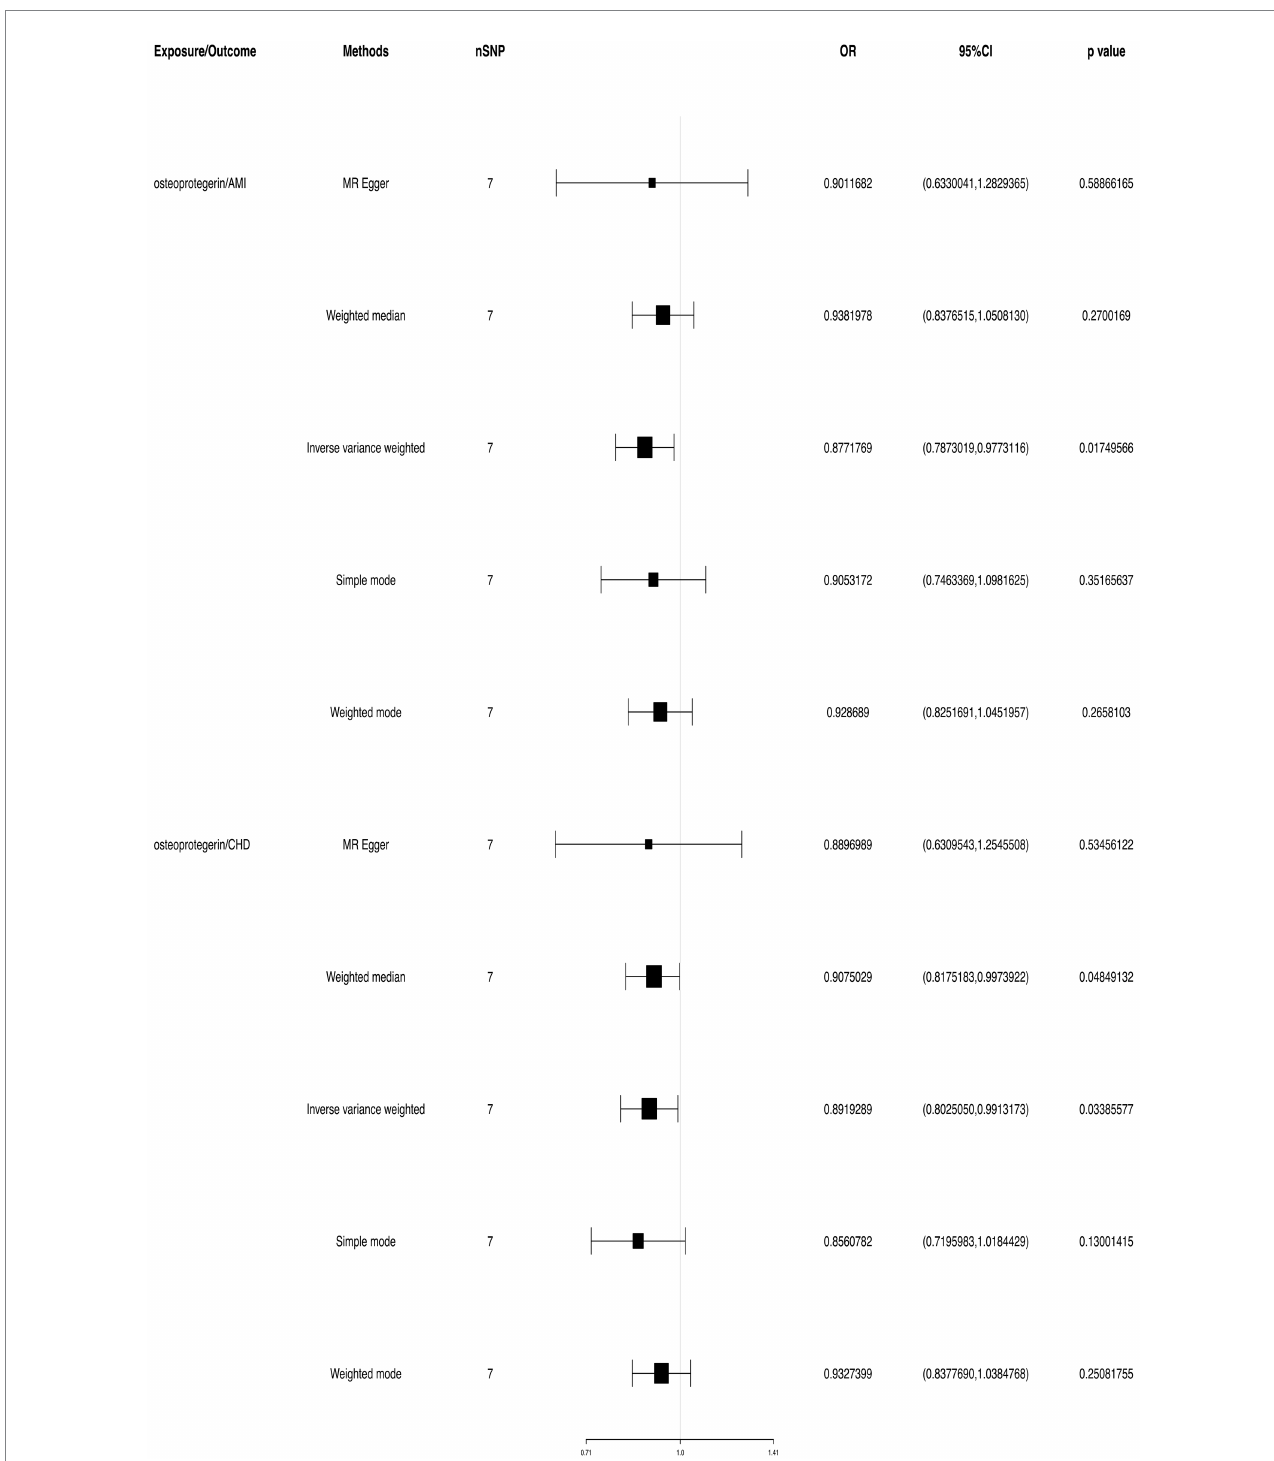
FIGURE 3 TSMR of plasma OPG and risk of AMI and CHD. We used the genome-wide association study (GWAS) of increasing plasma OPG level unit to summarize the statistics. The result was normalized to increase exposure by one unit. IVW, Inverse variance weighted; MR Pleiotropy RESidual Sum and Outlier; SNP, single-nucleotide